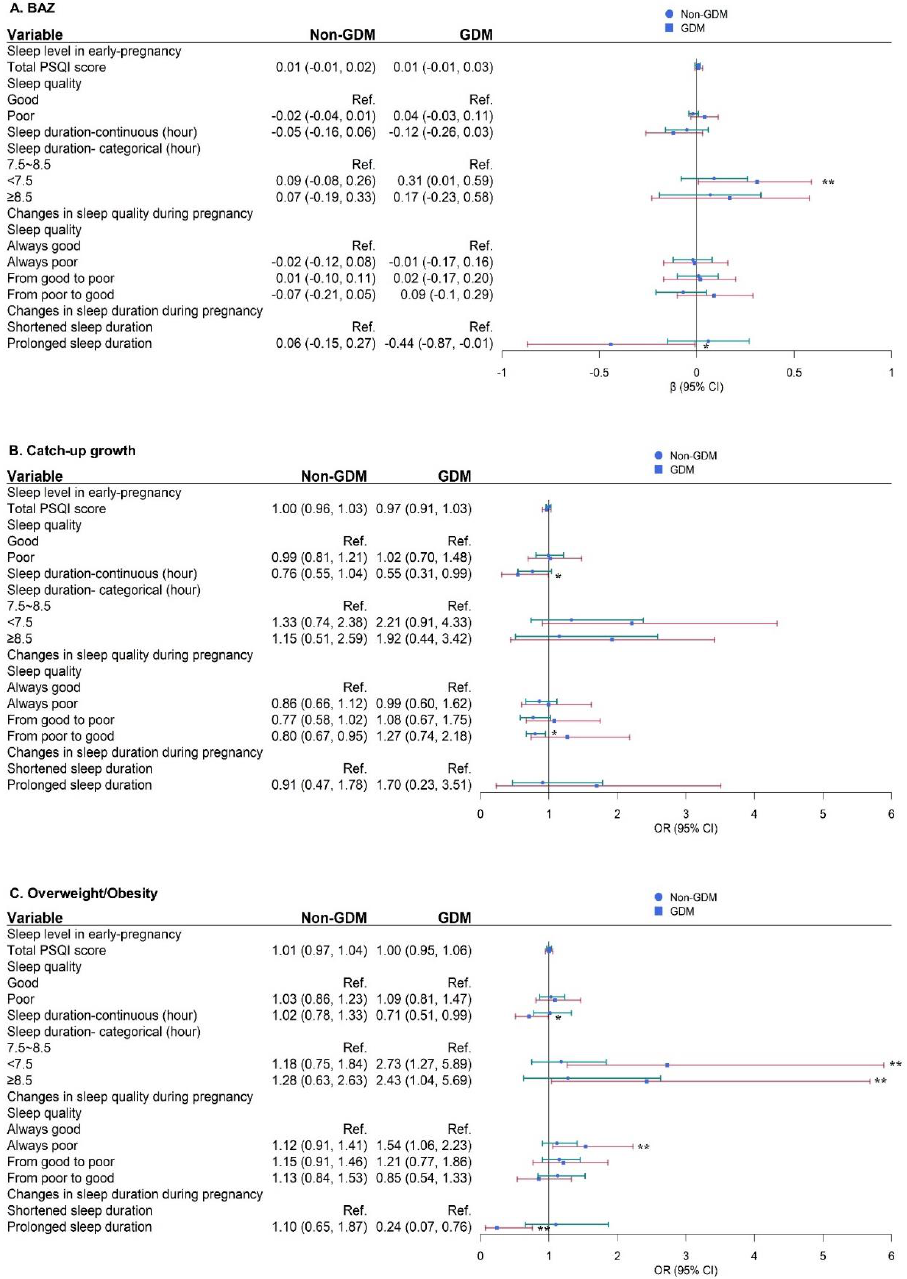
Figure 2. Effect of the maternal sleep pattern in early pregnancy and its change during pregnancy on physical growth of offspring within 24 months in the GDM subgroup [ β /OR (95% CI)]. ( A ) Outcome is BAZ (BMI Z-score); ( B ) Outcome is catch-up growth; ( C ) Outcome is overweight/obesity; Green line: In the non-GDM population, the effect values for each group comparison; Red line: In the GDM population, the effect values for each group comparison; ** p < 0.01, * p <